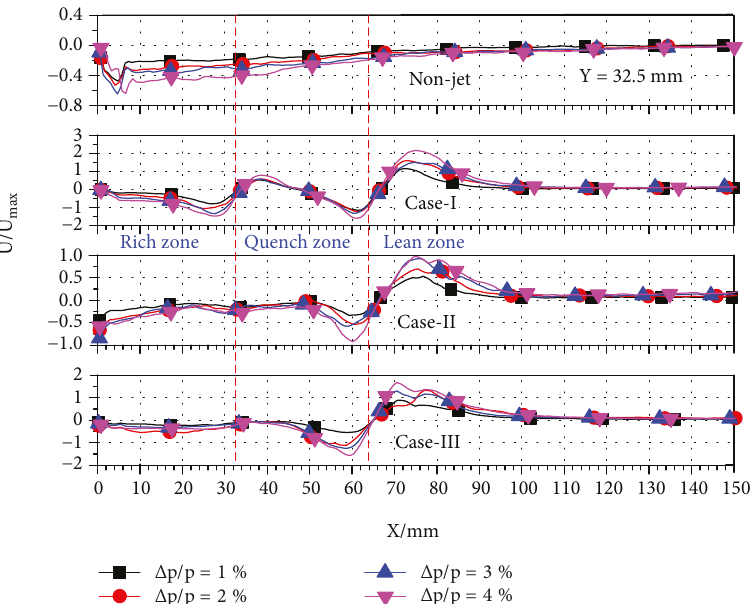
Figure 6: Axial velocity along the X direction at Y = 32 5 mm on the Z = 0mm plane.